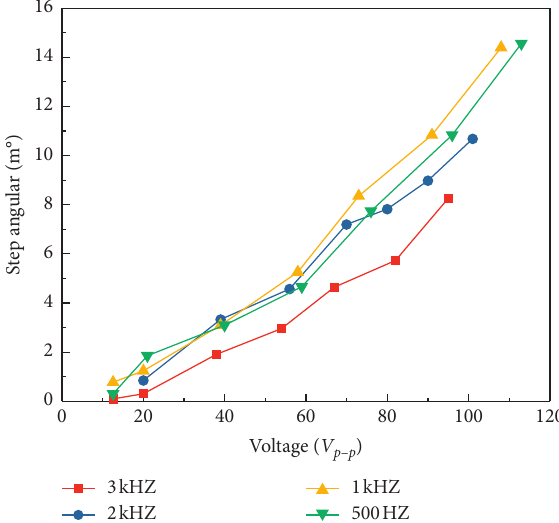
Figure 13: Velocity under different frequencies with a driving voltage of 93V.